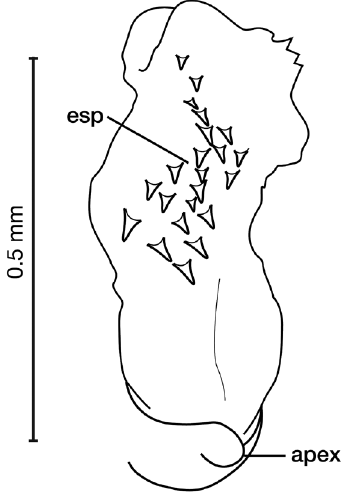
Figure 66. Line drawing of the phallus apex and endophallus, viewed laterally from phallus apex, of Dolichoctis dilatata sp. n.. Legend: esp endophallic spine patch; apex phallus